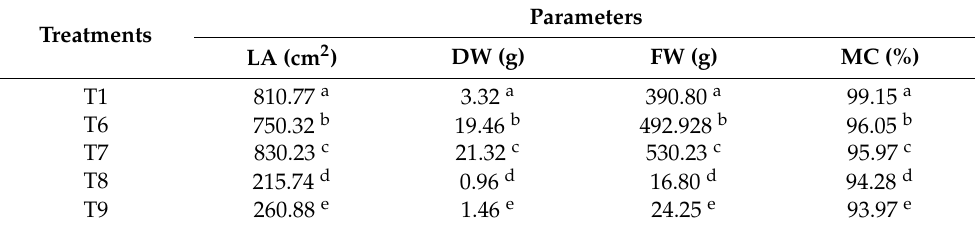
Table 6. The values of FW, DW, LA, and MC for T1, T6, T7, T8, and T9.